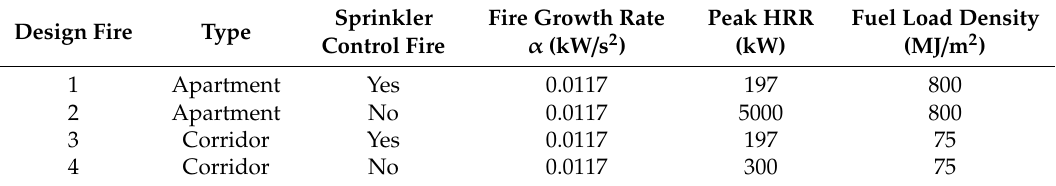
Table 5. Schematic design